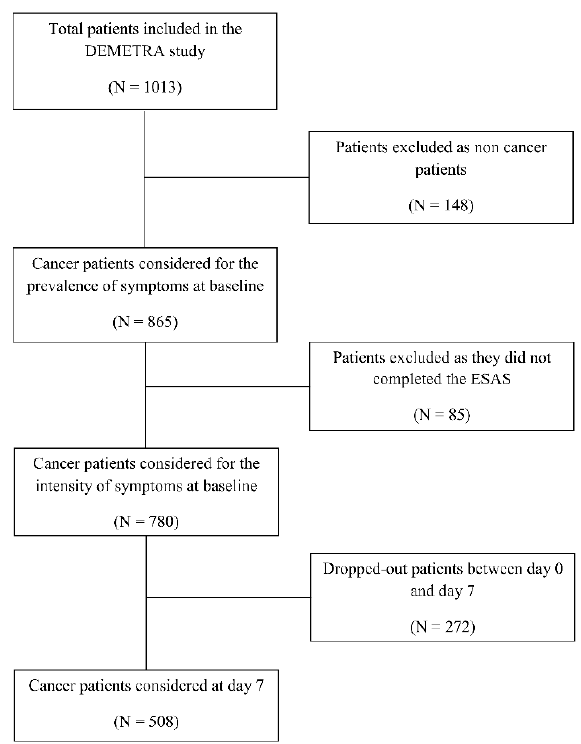
Figure 1. Flowchart of patients included in the study. ESAS, Edmonton Symptom Assessment System.